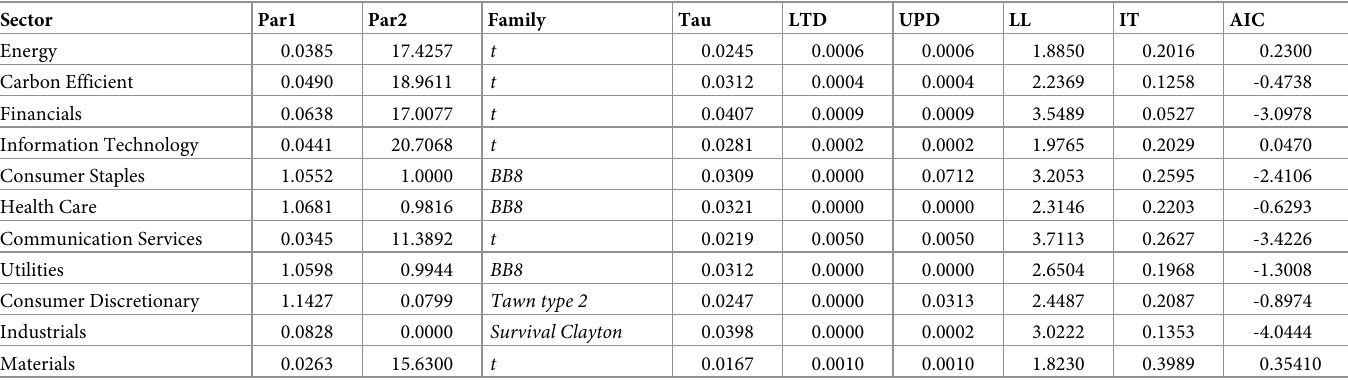
the diversification cost of a portfolio consisted of IEMV decrease during the COVID-19 crisis. In addition, adding the stock indices of the Information Technology sector and the energy sec- tor are the least and most costly way to build a portfolio of IEMV and each sectoral stock indi- ces during these periods. The results of hedging effectiveness are shown in Table 11. The result indicated that during the COVID-19 period, the hedge effectiveness of most of the hedged portfolios decrease, showing that the optimal weight strategy becomes less effective during the pandemic crisis due to high turmoil in the stock market. While during the Pre-EBOV, EBOV, and Pre-COVID periods hedging effectiveness are constant for optimal portfolios. Finally, stock indices energy, financial, and materials are the most effective assets to diversify the port- folio. While adding stock indices of Consumer Discretionary, Communication Services, Infor- mation Technology for diversification purposes is not recommended.